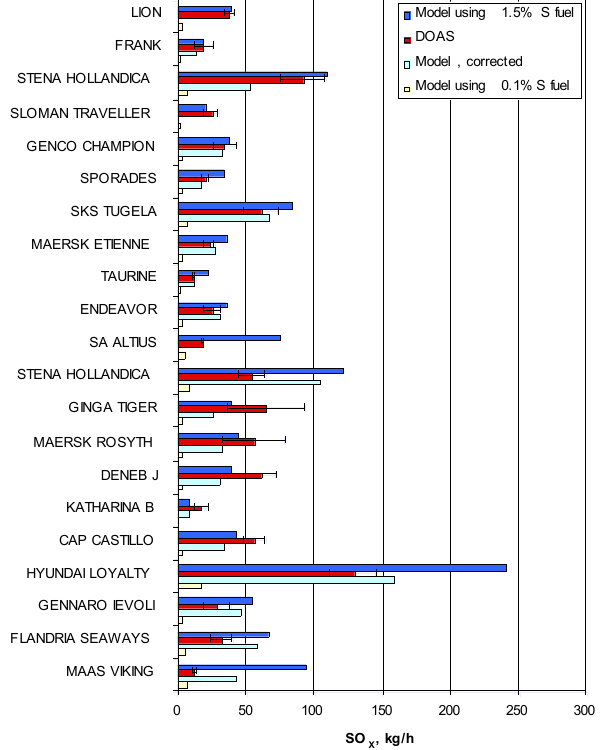
Figure 9. Comparison of DOAS measurements performed by heli- copter (in red), the modelled SO x emission from the targeted ves- sel (assuming 1.5%(m/m) fuel sulphur ratio for main engines and 0.5%(m/m) for auxiliaries, in blue), the modelled emissions cor- rected with the sniffing measurement (taken sulphur ratio deter- mined by sniffing), and the model results for a future scenario where ships run with 0.1%(m/m) sulphur